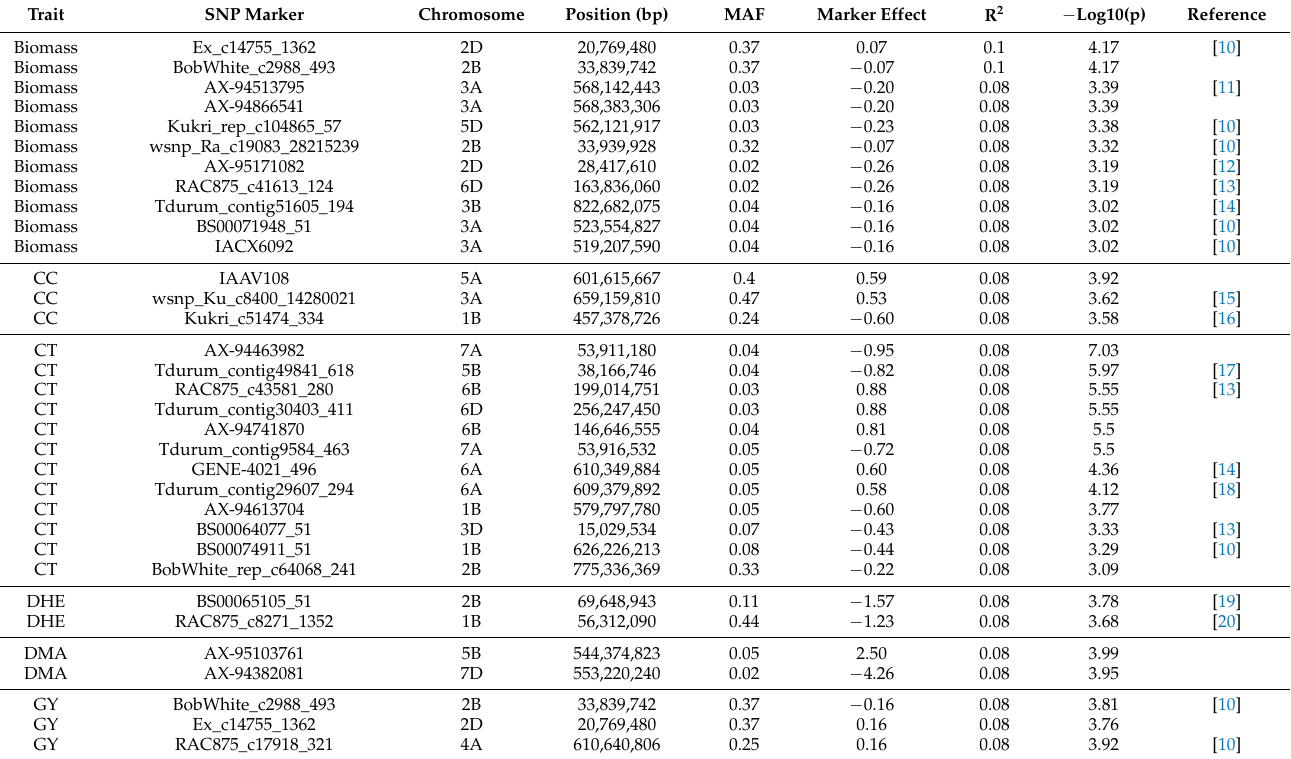
Figure 6. Marker density on each bread wheat chromosome of 200 bread wheat genotypes. Table 2. List of the significant markers associated with Biomass, CC, CT, DHE, DMA, GY, NPM, NSS, NTP, and PLH from genome-wide association analysis of 200 bread wheat genotypes under the rainfed conditions at Sidi Al-Aidi